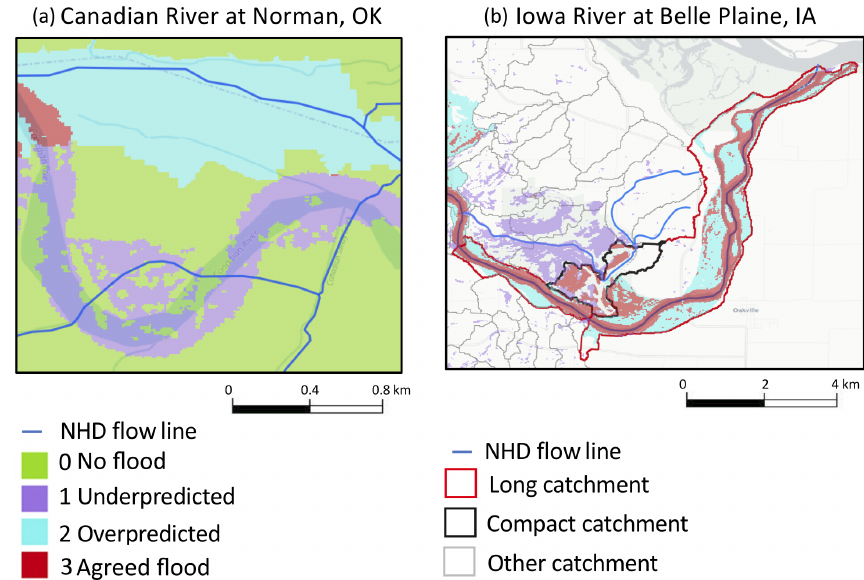
Figure 8. Unaccounted-for challenges when using the NHD as a modeling fabric. (a) This catchment shows a case where the NHD and NED are not capturing the true meander of a river channel. (b) This set of catchments highlights the influence of long nonuniform catchments and challenges with catchment